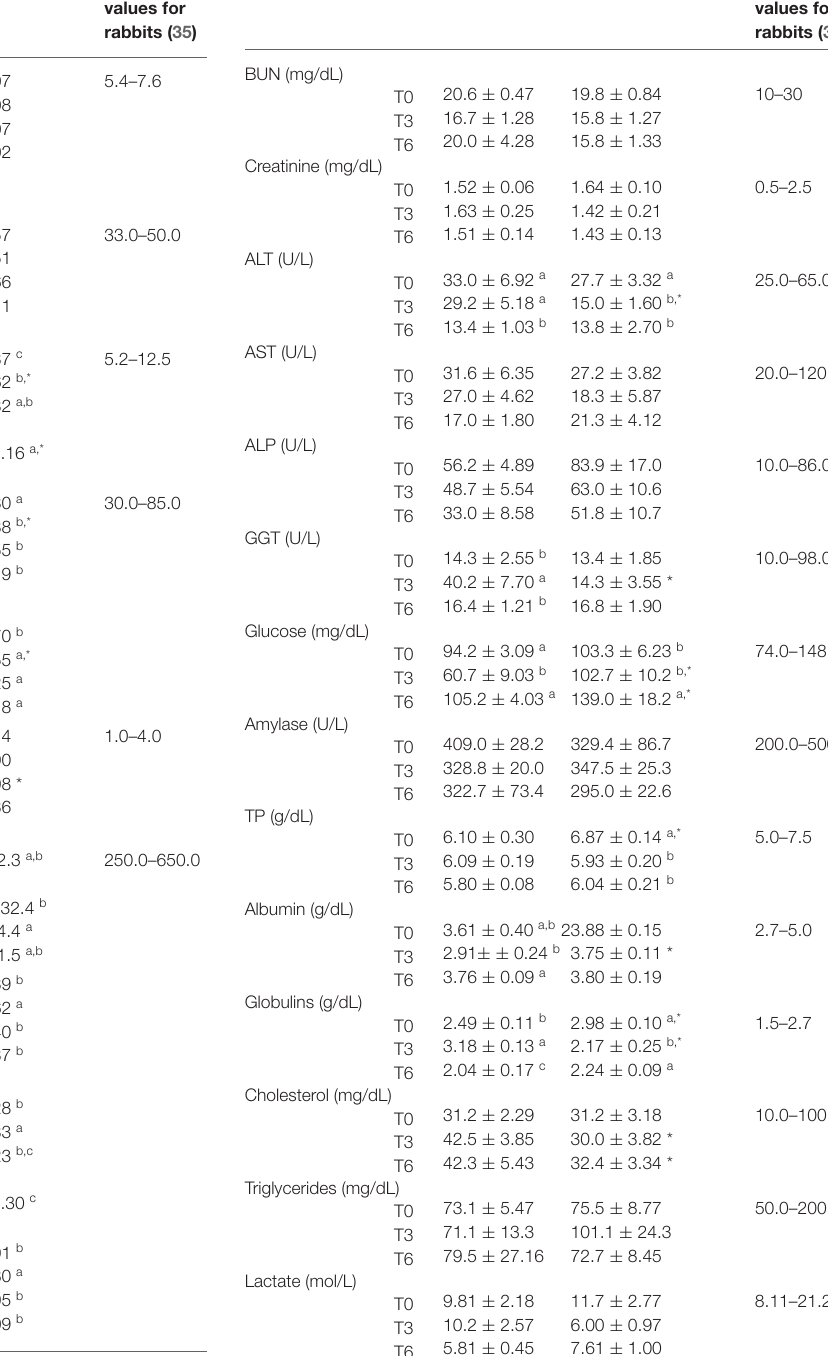
BUN, blood urea nitrogen; ALT, alanine aminotransferase; AST, aspartate transaminase; ALP, alkaline phosphatase; GGT, gamma-glutamyl transferase; TP, total protein. a , b , c Different letters in the same column show statistical difference between experimental moments in the same group (mixed linear model, p < 0.05). * Statistical difference to control group in the same day (mixed linear model, p < 0.05). Data are presented as mean ±